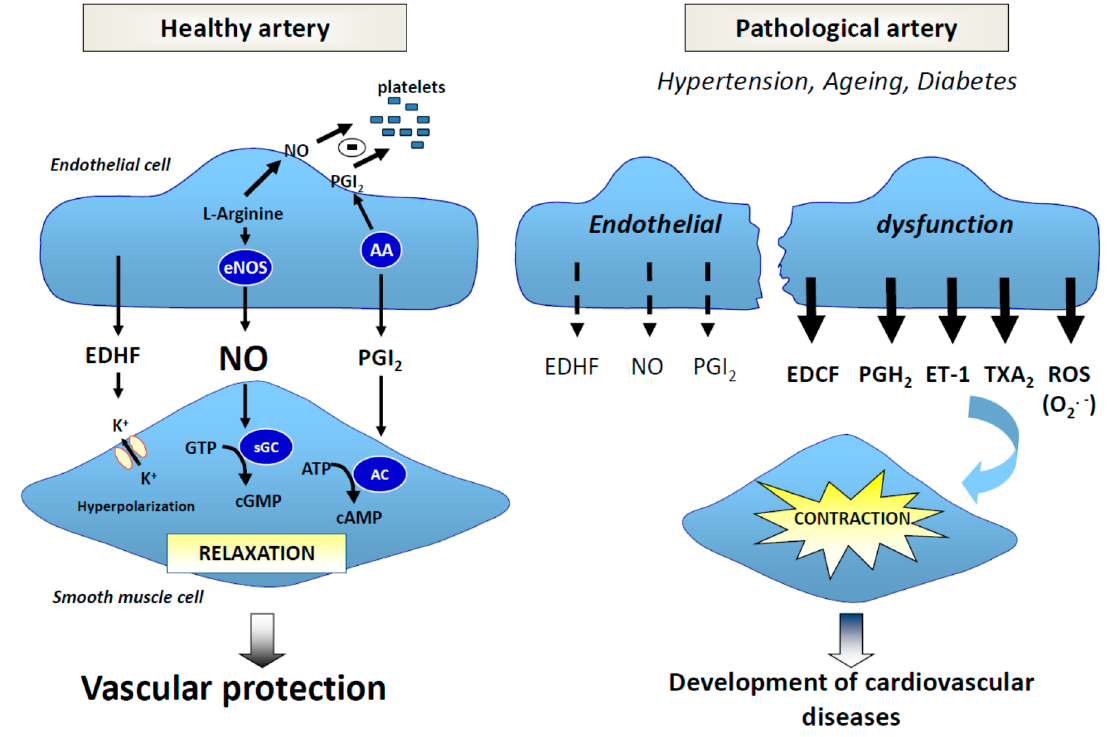
Figure 6. Role of endothelium in vascular homeostasis. In a healthy artery, vasodilators factors such as nitric oxide (NO), endothelium-derived hyperpolarizing factor (EDHF), and prostacyclin (PGI 2 ) play a key role in homeostasis. In a pathological artery, they decrease in favor of contractor factors such as endothelium-derived contracting factor (EDCF), prostaglandin (PGH 2 ), endothelin-1 (ET-1), and thromboxane A 2 (TXA 2 ) in the presence of oxidative stress and superoxide anions (O 2. − ). AA: arachidonic acid, eNOS: endothelial nitric oxide synthase, sGC: soluble guanylate cyclase; AC: adenylate cyclase; K + : potassium.